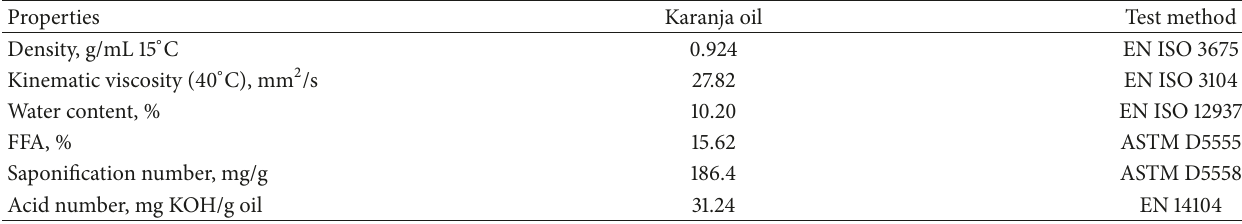
Table 2: Properties of crude karanja oil before transesterification and test methods used.